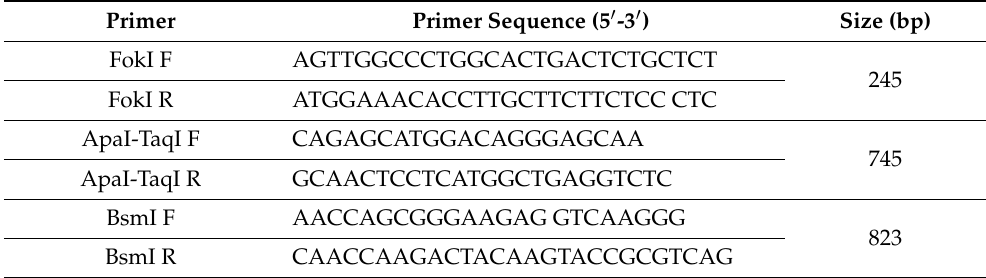
F, forward primer; R, reverse primer; bp, base